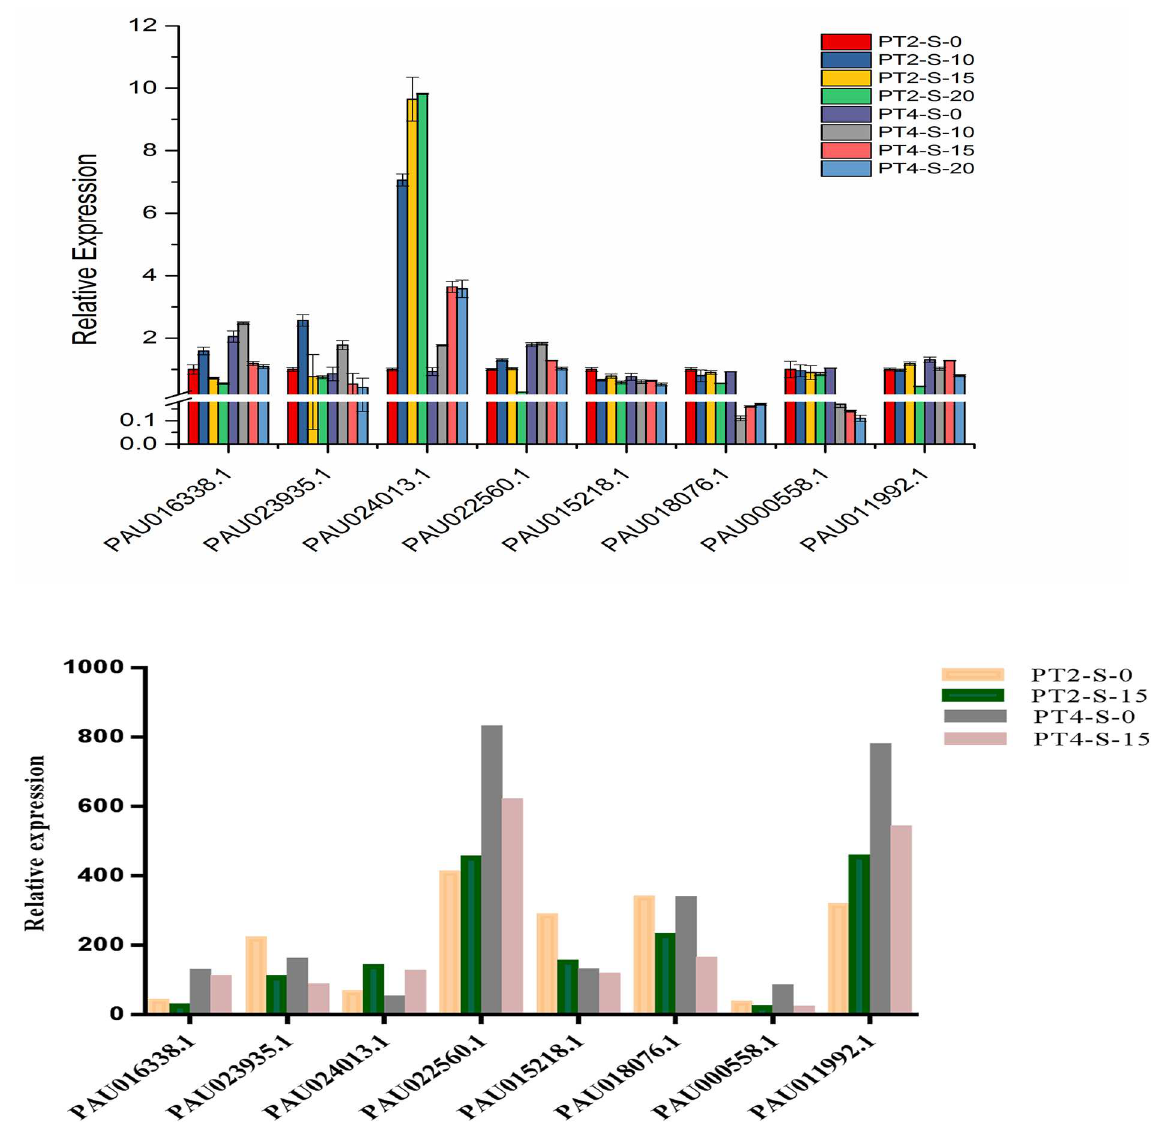
Fig 8. Expression pattern confirmation of selected genes by qRT-PCR. (A) Quantitative Real-TimePCR (qRT-PCR) analysisof 8 selecteddifferentiallyexpressed genes. 18S rRNA was used as the internalreference gene. For each group, the PT2 (S-0) expressedlevel was considered as 1.00, and other samples were normalizedaccordingly. Standarderror of the mean for three technicalreplicatesis representedby the error bars. S-0, S-10, S-15, and S-20 (0, 10, 15, and 20 days), 0.4% NaCl salt-treated for PT2 and PT4, respectively.(B) Changesin the relative expressionlevels of 8 selectedgenesas determined by RNA-Seq.